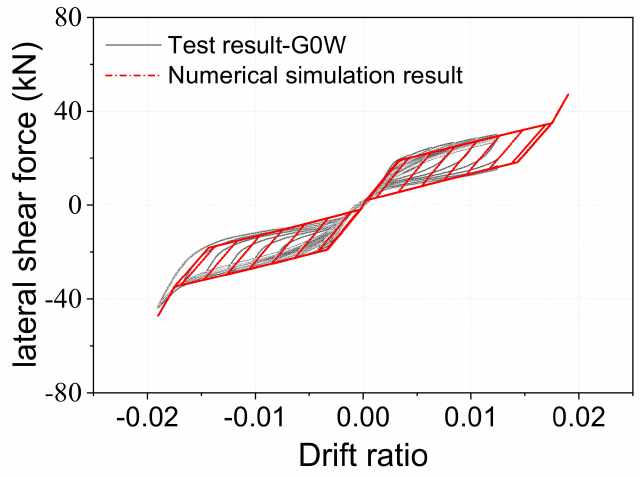
Figure 3. Shear force–drift ratio hysteretic curves of the test and numerical simulation results.